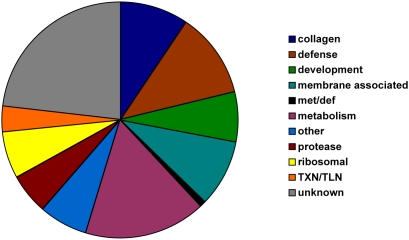
Gene Ontology terms for the 204 identified differentially expressed genes.GO terms were amended with recently published information and used to categorize the identified differentially expressed genes. Clustering was done manually by grouping GO terms of similar function. TXN/TLN = transcription/translation-related, met/def = roles in both metabolism and defense. Other = groups represented by two or less members.